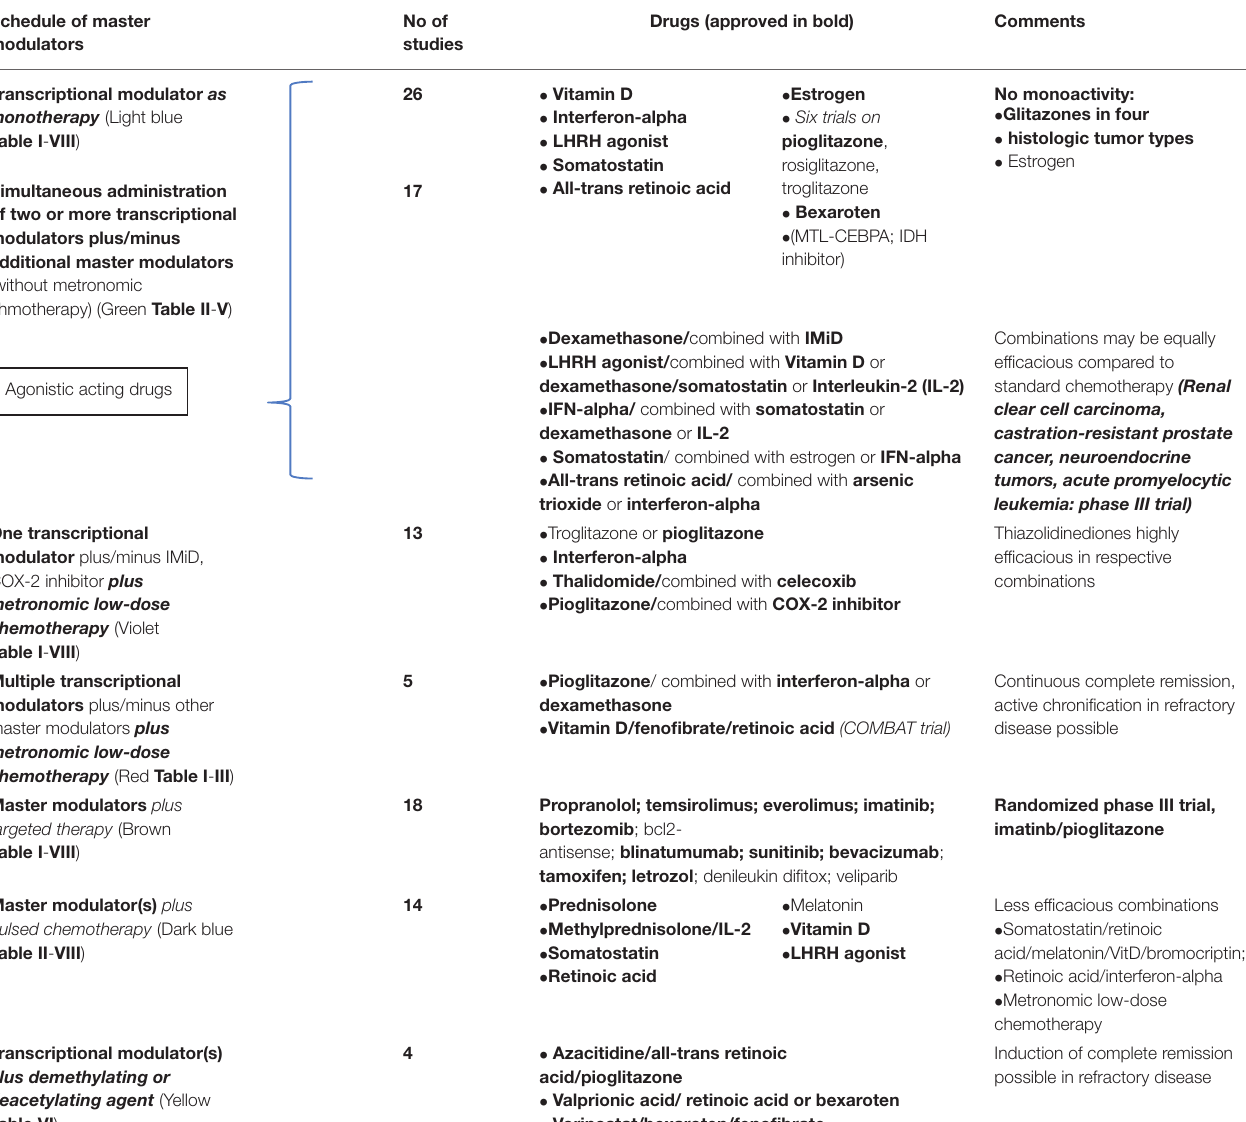
TABLE 1 | Master modulators including transcriptional modulators in 97 clinical trials: Master modulators are transcriptional modulators (hormones, cytokines, vitamins etc.), metronomic low-dose chemotherapy, protein-binding drugs (arsenic trioxide, COX-2 inhibitors, IMiDs etc.), metabolic active drugs, such as PPAR gamma/ α agonists, statins, and metformin (interventional statin and metformin trials are not included in the review; also, not included nuclear receptor antagonists). Ninety-seven studies including master modulators (25 histologic entities). Dysregulated transcription programs: Cancer cells are highly dependent on regulators of gene